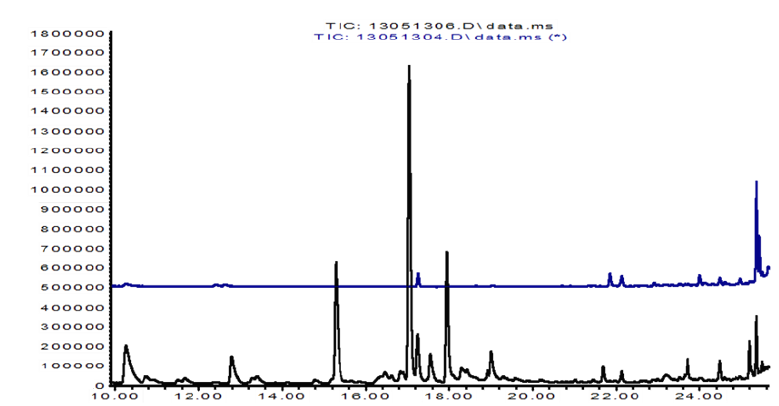
Figure 6. Removal of volatile terpenes emitted from a non-sterile beechwood/soil mix (below) by monoxenic F. pinicola (above). Main compounds, below: 10.255 (min), alpha-pinene; 12.783, ( + )-3-carene; 15.287, fenchone; 17.047, camphor; 17.545, trans-3-pinanone; 17.959, cis-3-pinone;